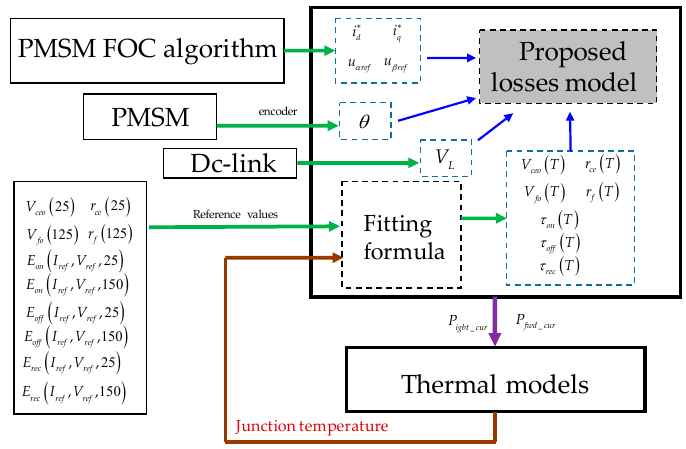
Figure 11. The principle of the electro–thermal interaction for the losses calculation.